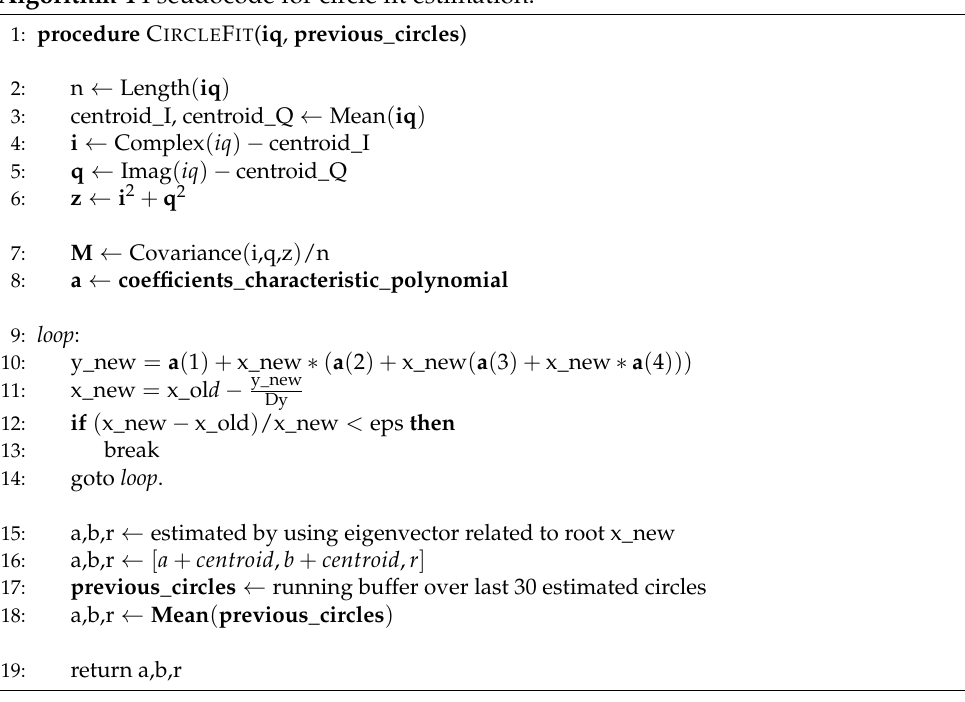
Algorithm 4 Pseudocode for circle fit